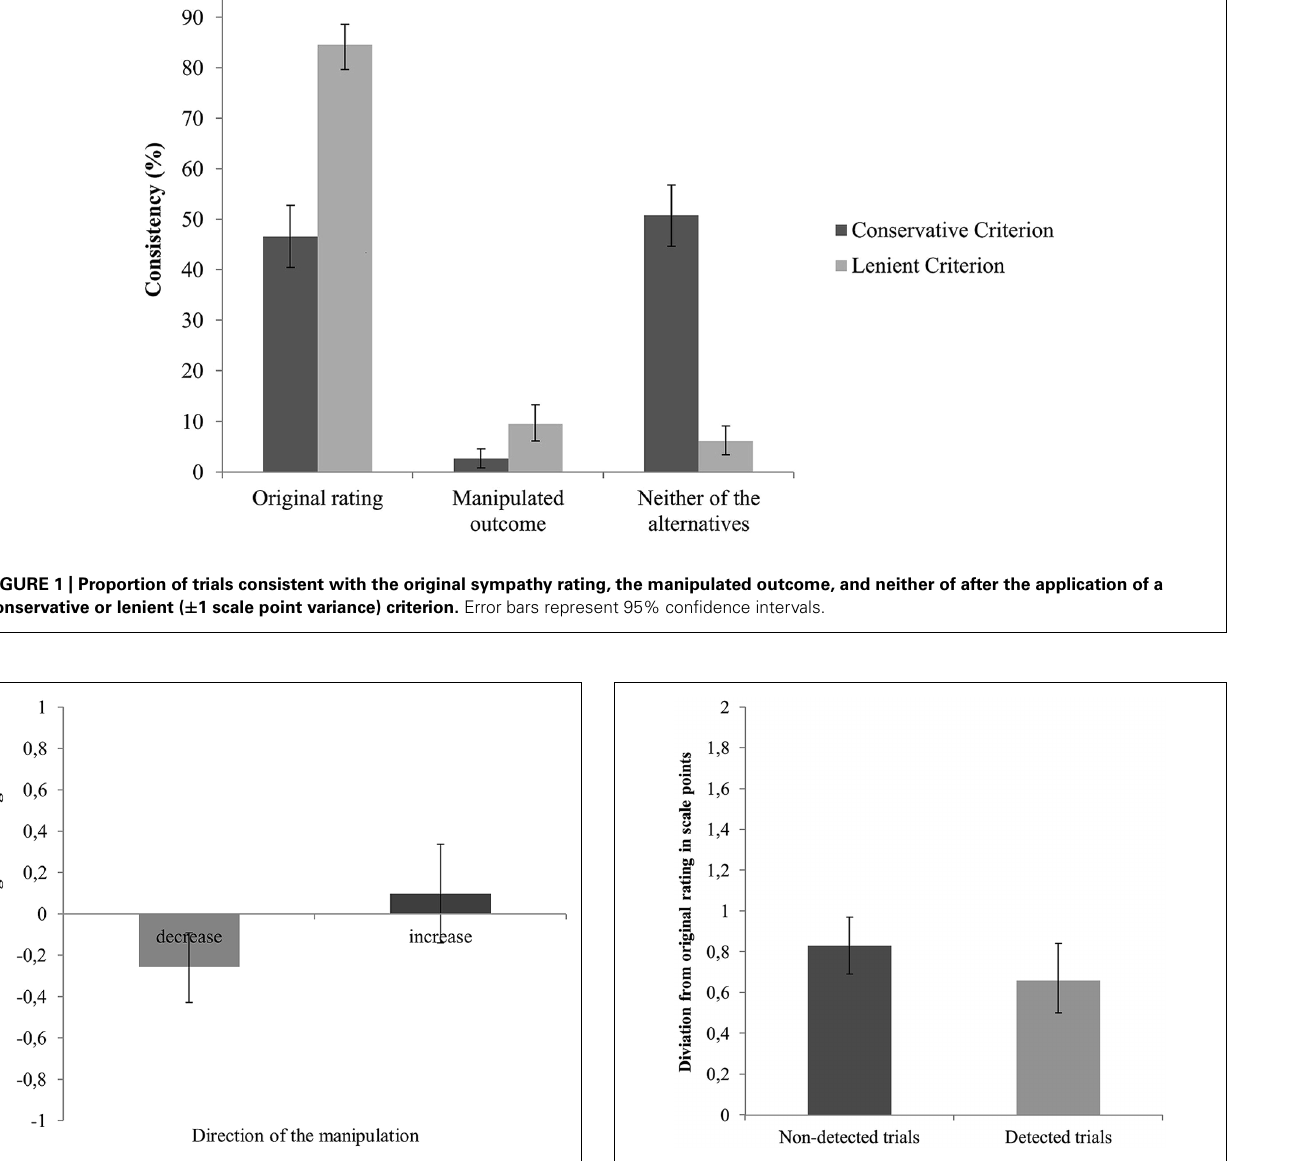
FIGURE 2 | Mean distance from the original sympathy rating as a function of manipulation direction (increase vs. decrease). Error bars represent 95% confidence intervals.